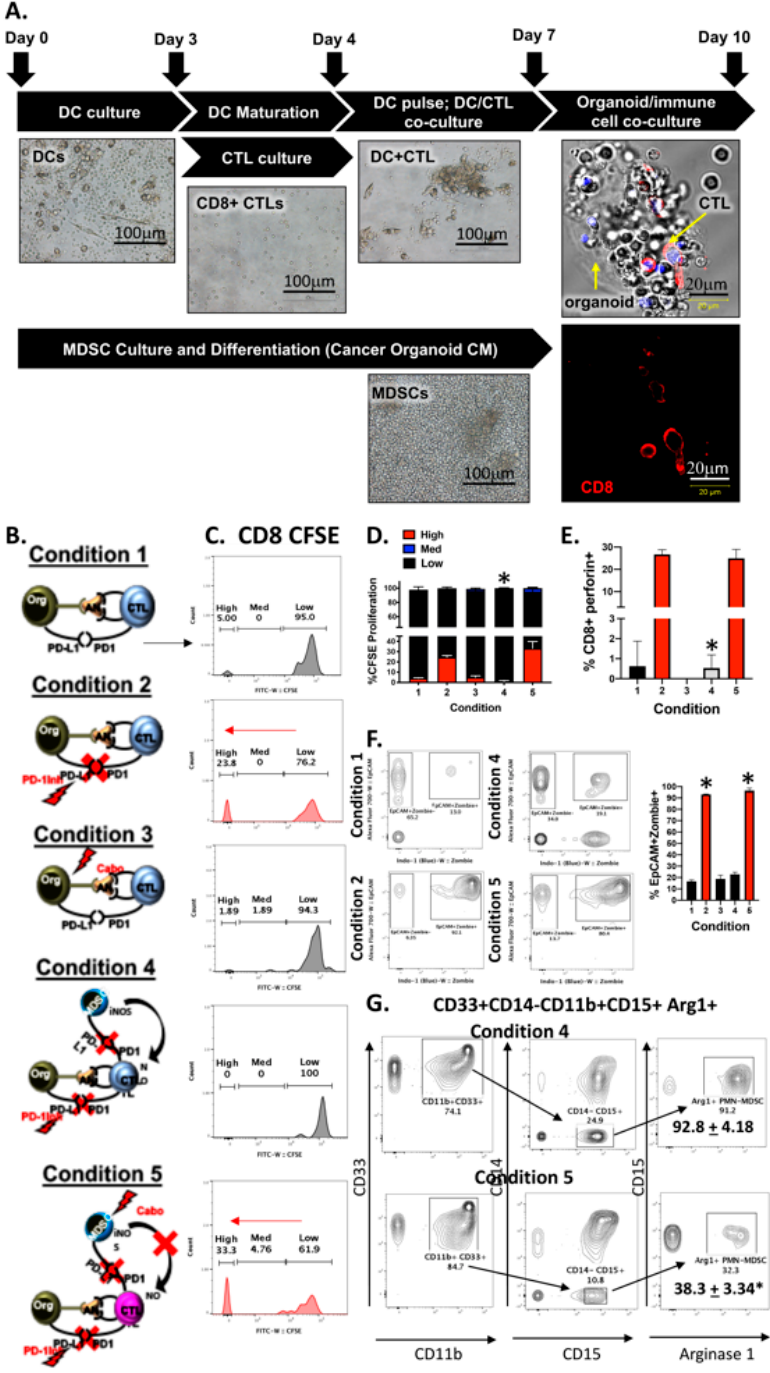
Figure 7. Analysis of patient-derived autologous PDAC organoid / immune cell co-cultures. ( A ) Light micrographs of representative images of patent-derived immune cells cultured with PDAC organoids. ( B ) Schematic representation of experimental conditions 1–5 used in organoid / immune cell co-cultures. ( C ) Histograms generated from CFSE T cell proliferation assays using co-cultures under treatment conditions 1–5. Percent of ( D ) proliferating CTLs, and ( E ) CD8 + perforin + -expressing cells in co-cultures under treatment conditions 1–5. ( F ) Representative contour plots were quantified for changes in EpCAM + PD-L1 + zombie (dead) tumor cells within co-cultures under treatment conditions 1–5. ( G ) Representative contour plots were quantified for changes in arginase 1 expression in PMN-MDSCs within co-cultures under treatment conditions 1–5. * p < 0.05; n = 10 individual patient-derived co-cultures.